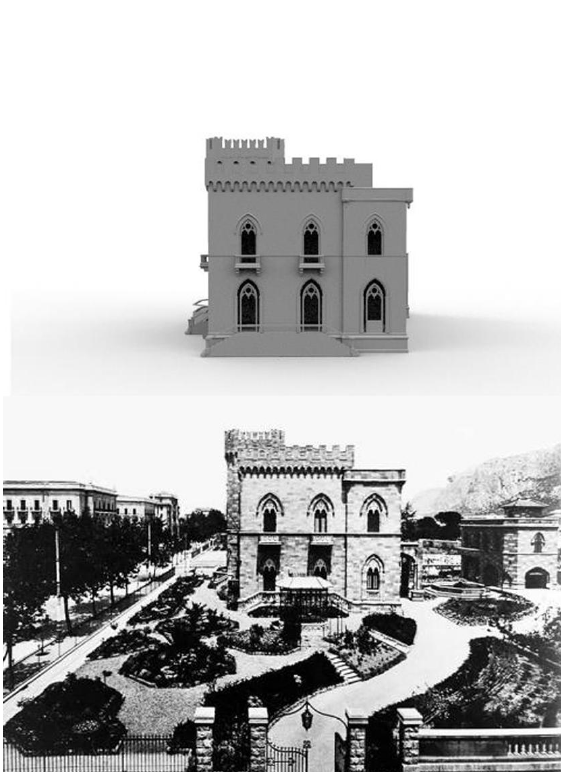
Figure 6 . Three-dimensional reconstruction and relative historical